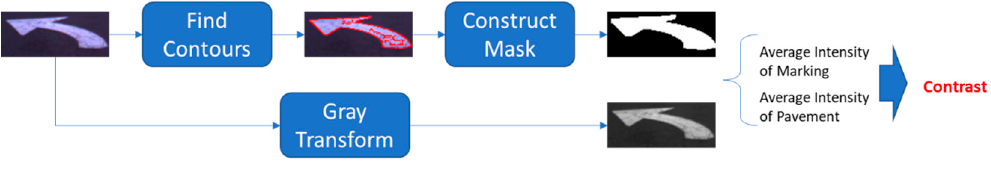
Figure 5. A demonstration of the pipeline of the visibility analysis module.